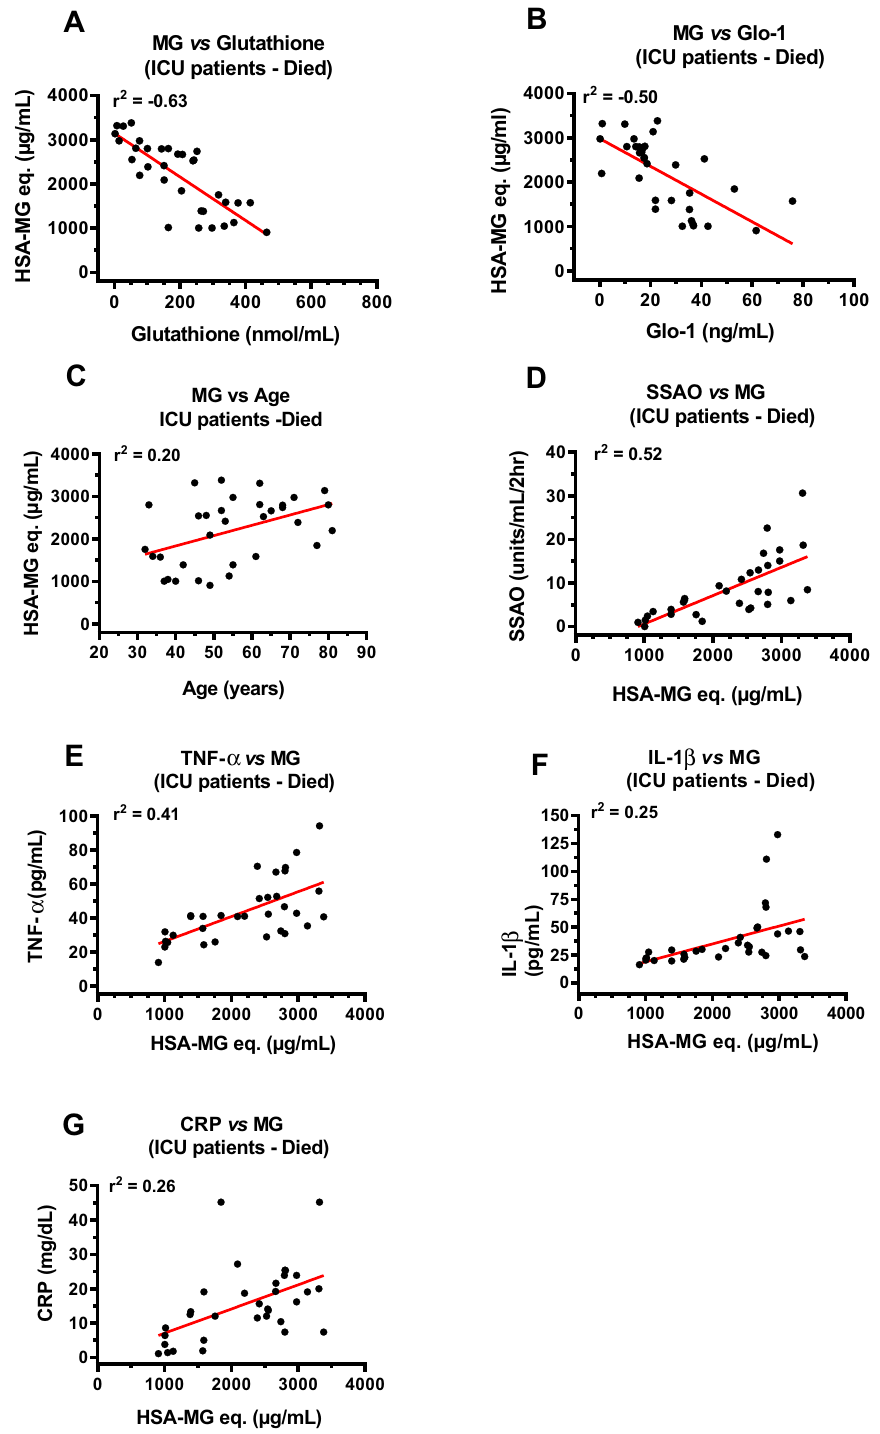
Figure 10. Correlations between plasma MG and glutathione, Glo1, SSAO, TNF-α, IL-1β and CRP in ICU patients that died. ( A , B ) Strong inverse correlation between MG and glutathione (r 2 = − 0.63), and MG and Glo1 (r 2 = − 0.50) in ICU COVID-19 patients that died. ( C ) Weak correlation between plasma MG and age (r 2 = 0.20) in ICU COVID-19 patients that died. ( D ) Strong positive correlation (r 2 = 0.52) between plasma MG and SSAO activity in ICU patients that died. ( E ) Moderate positive correlation (r 2 = 0.41) between plasma MG and TNF-α in ICU COVID-19 patients that died. ( F , G ) Weak correlation between plasma MG and IL-1β (r 2 = 0.25) and between MG and CRP (r 2 = 0.26) in ICU COVID-19 patients that died. Data in graphs are for n = 33